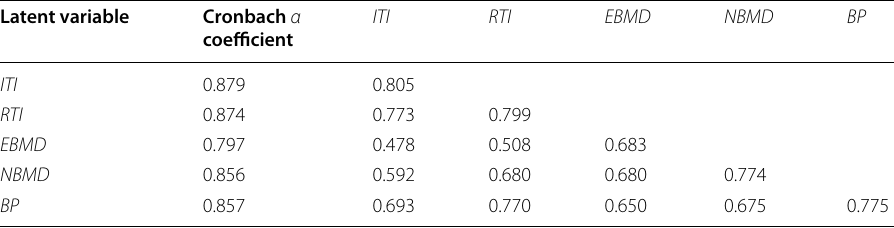
The diagonal number is the square root of AVE